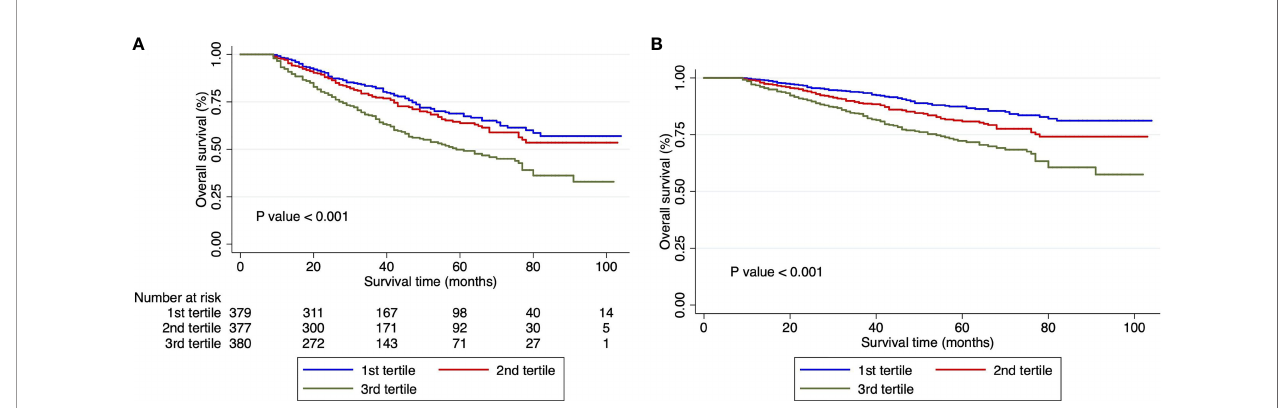
FIGURE 1 | Survival curves in patients with hepatocellular carcinoma undergoing hepatectomy according to De-Ritis ratio tertiles. (A) Unadjusted Kaplan – Meier survival curves. (B) Adjusted survival Kaplan – Meier curves; curves were adjusted for Barcelona Clinic Liver Cancer stage, albumin – bilirubin grade, cancer thrombus, tumor capsule, and hepatitis B virus DNA. Ratio, tertiles of the aspartate transaminase/alanine